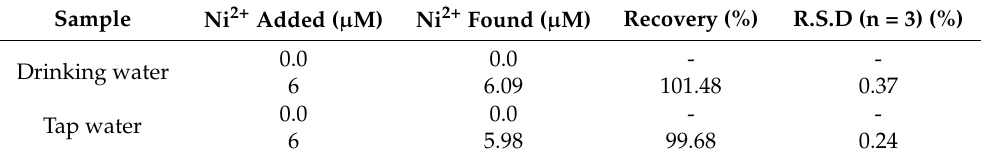
Figure 9. Photographs of DPP -coated test strips (1 mM). ( a ) DPP -test strips immersed in Ni 2+ (10, 50, and 100 µ M). ( b ) DPP -test strips immersed in varied metal ions (50 µ M). The real water sample analysis was performed to determine the spiked Ni 2+ in samples collected from drinking and tap water (Table 2). Table 2. Determination of Ni 2+ a